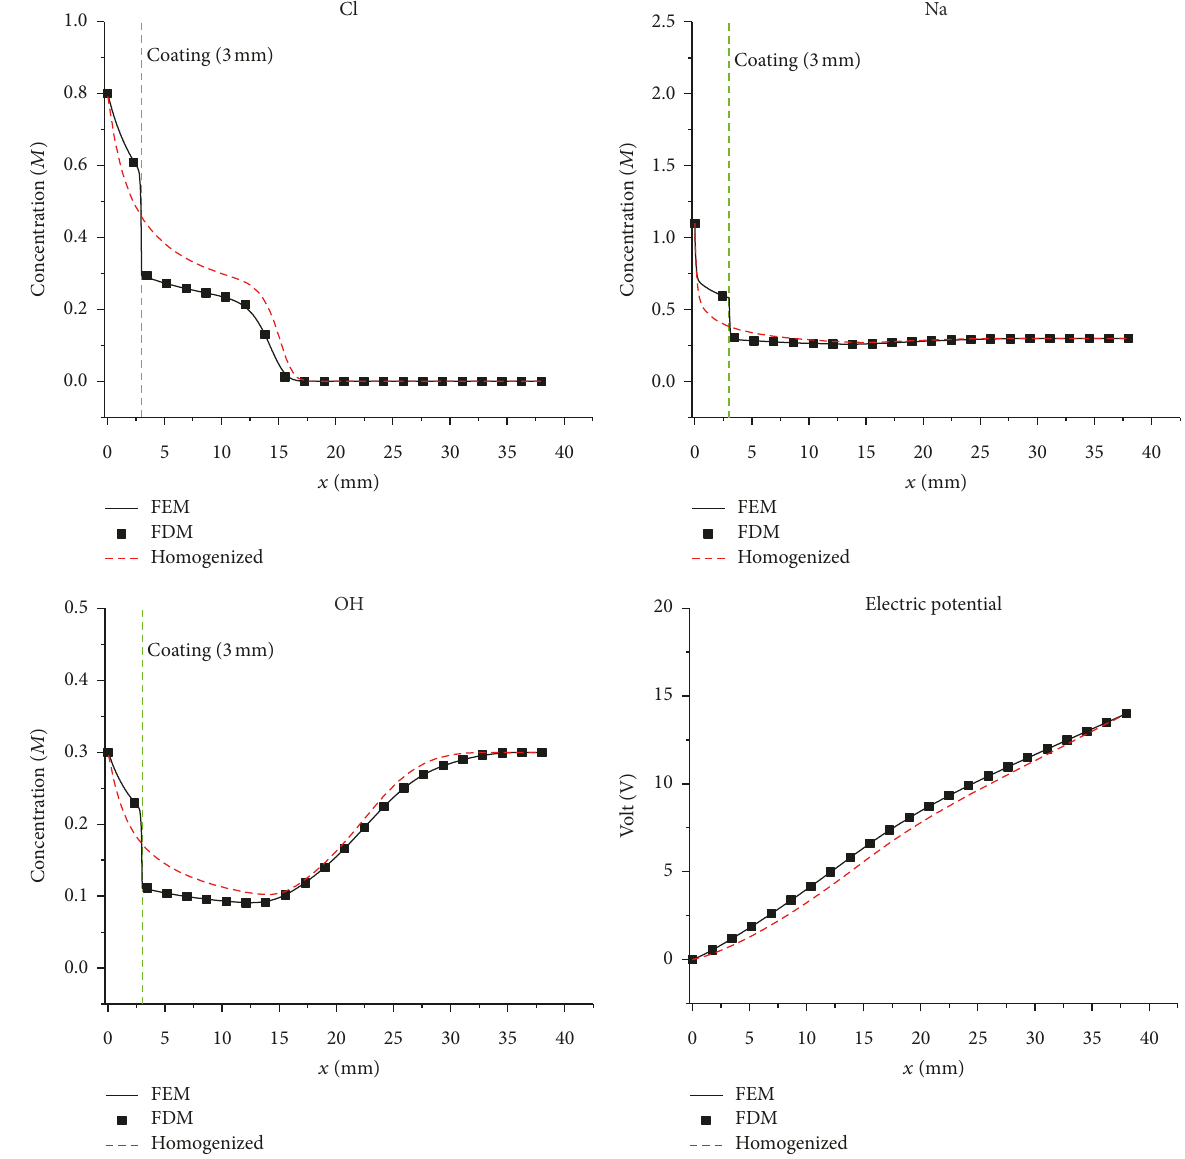
Figure 7: Ionic and electric potential profiles after 12-hour migration test ( 𝐷